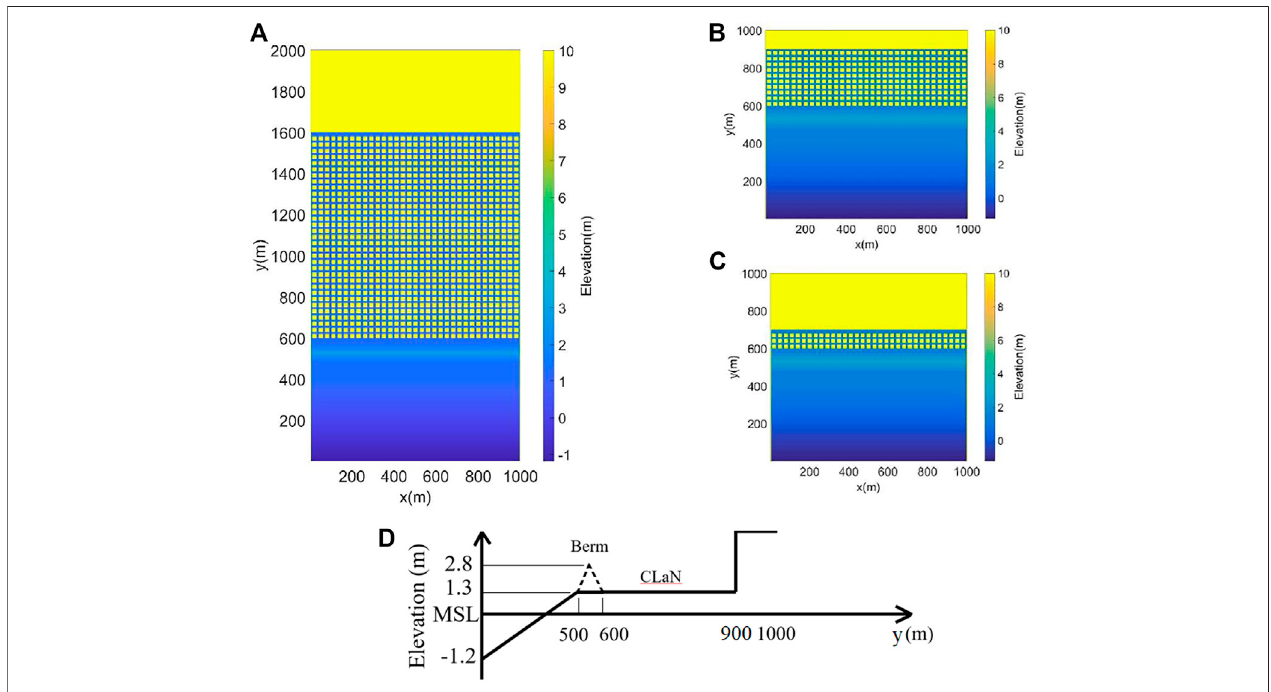
FIGURE2| LandelevationplanformforidealizedmodelgridswithCLaNs ’ aspectratioof (A) 1:1, (B) 3:1,and (C) 11:1. (D) Schematiccross-sectionaldiagramofAR3: 1, with the dotted line denoting the berm as one option for adaptation. Berm protection is shown as a dashed line and retreat is not shown (the CLaNs are fully populated).